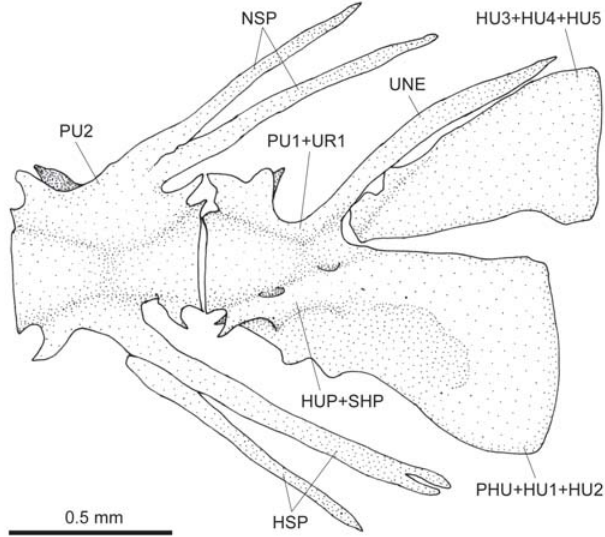
Fig. 9. Caudal skeleton of Ituglanis macunaima , paratype, LIRP 5642 (29.1 mm SL), left lateral view. Abbreviations: HSP, hemal spine; HUP+SHP, hypurapophysis-secondary hypurapophysis fused; HU3+HU4+HU5, fused hypural 3- hypural 4-hypural 5; NSP, neural spine; PHU+HU1+HU2, fused parhypural-hypural 1-hypural 2; PU1+UR1, preural 1-ural 1 compound centrum; PU2, preural centrum 2; UNE,